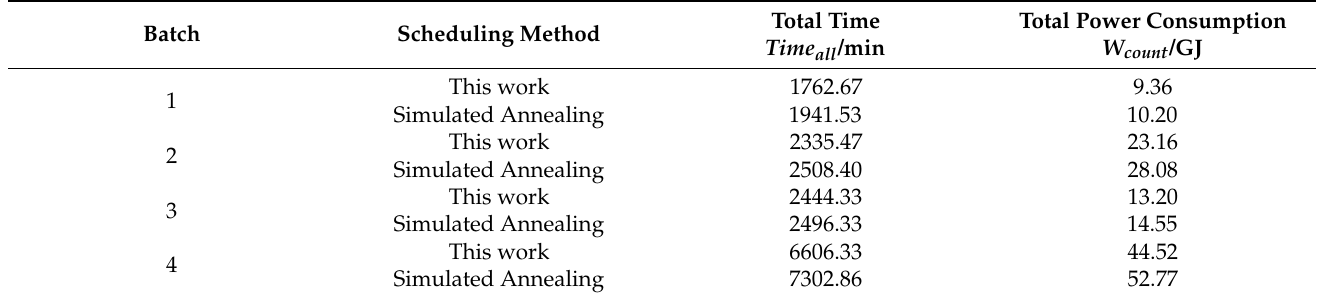
Table 5. Scheduling optimization results of each